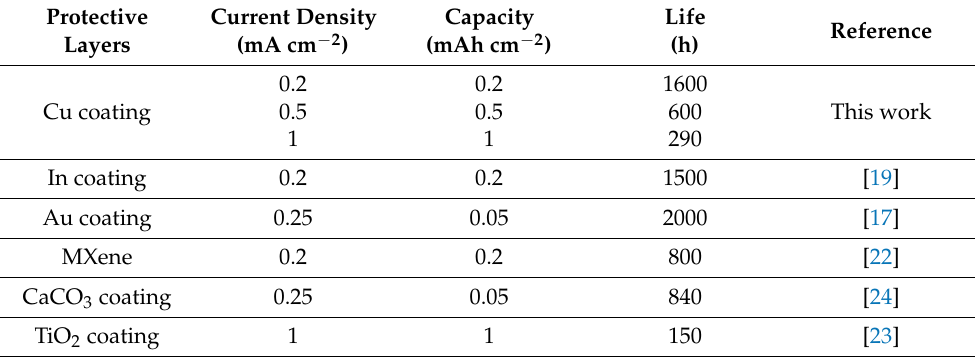
Table 1. Comparison of the performance of Cu–Zn symmetric cells with recent literature on various Zn surface modification strategies.